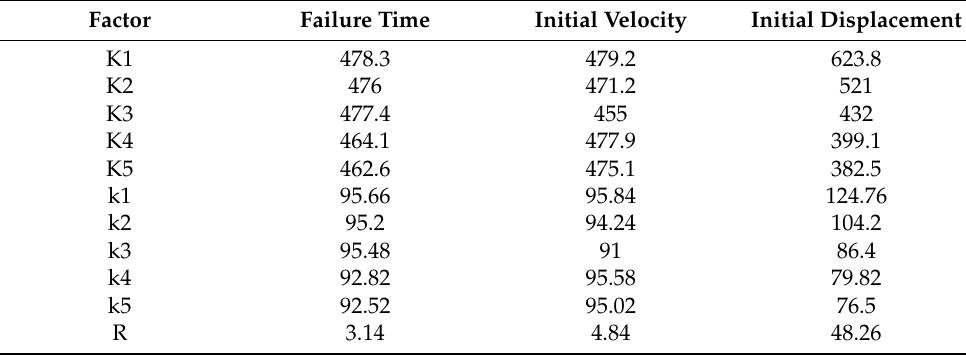
Table 3. Orthogonal test table when bottom side column